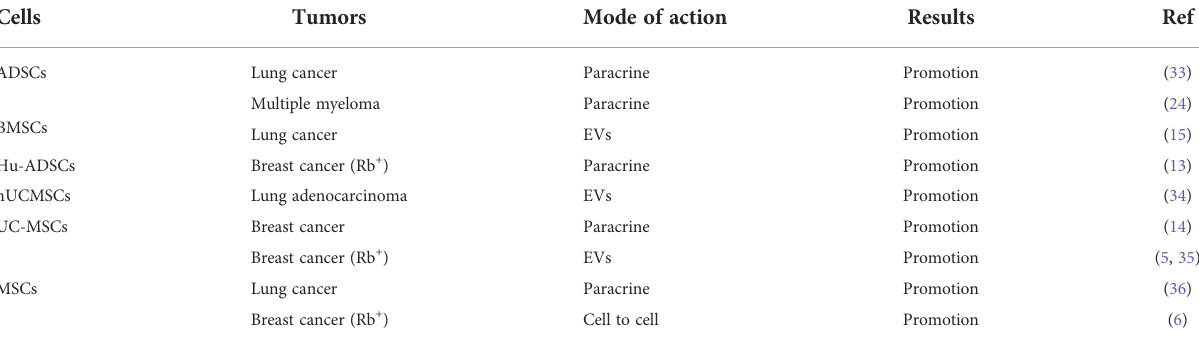
TABLE 3 The promoting effect of MSCs in cancers.